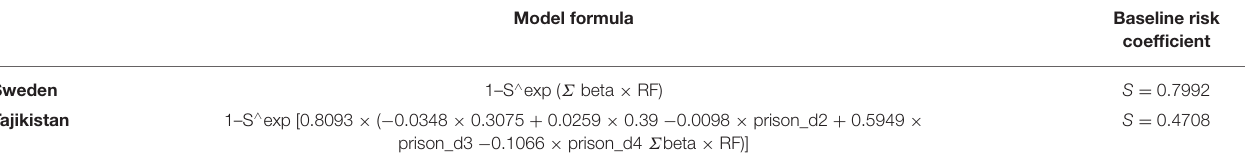
TABLE 2 | Recalibrated model formula.